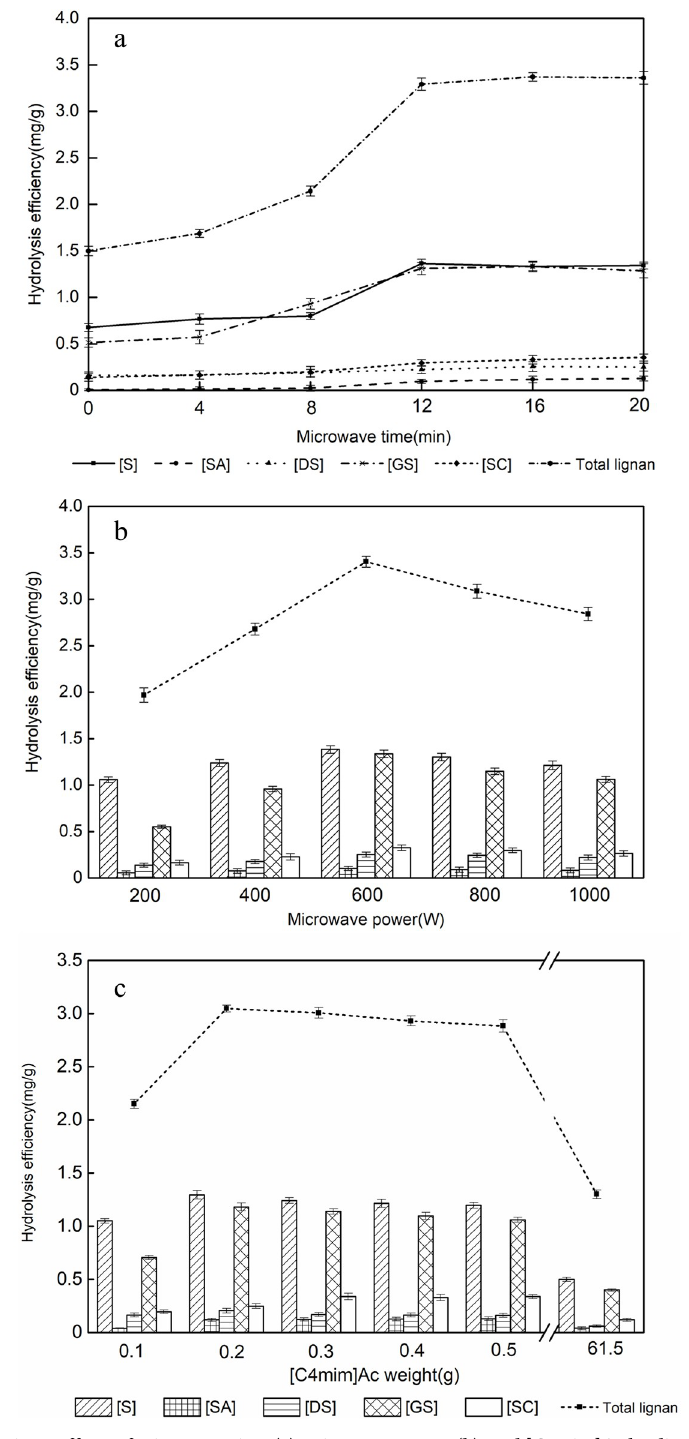
Fig 5. Effects of microwave time (a), microwave power (b), and [C4mim]Ac loading (c) on the hydrolysis efficiency of FBCLs.